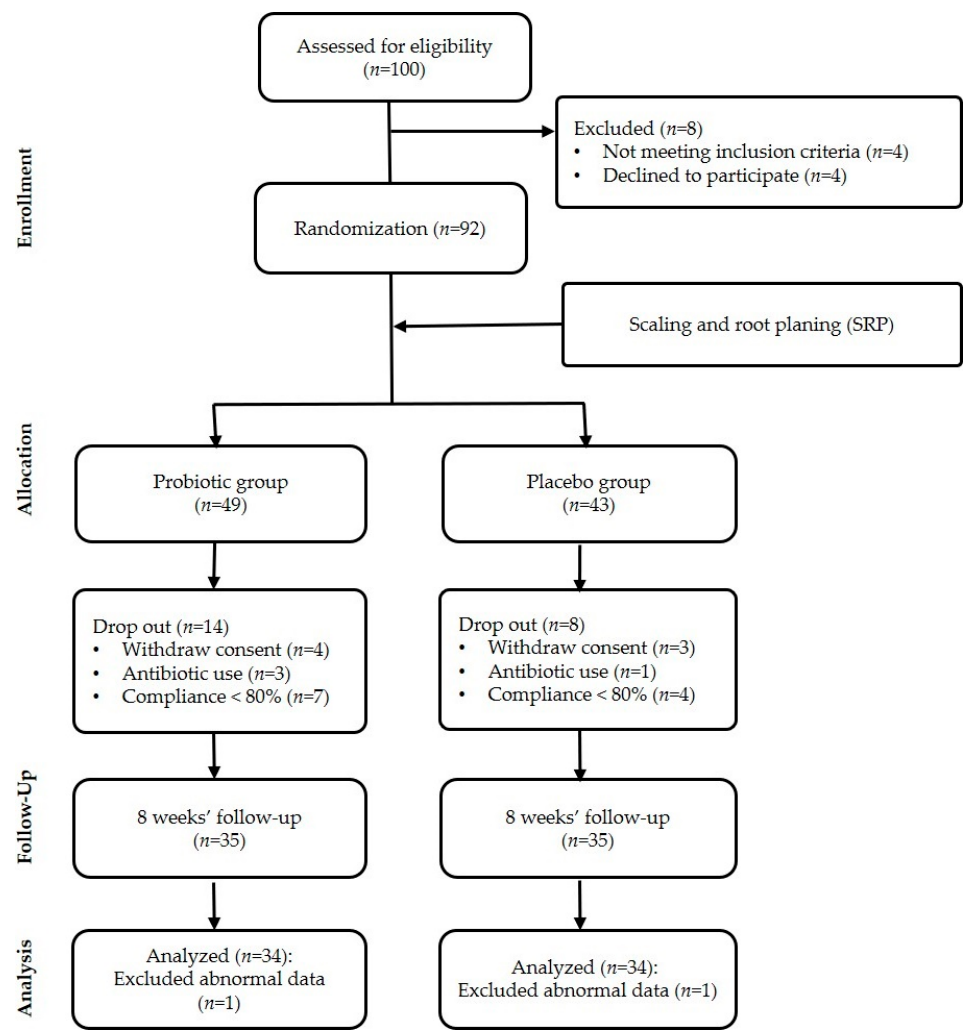
Figure 2. Research flow diagram.